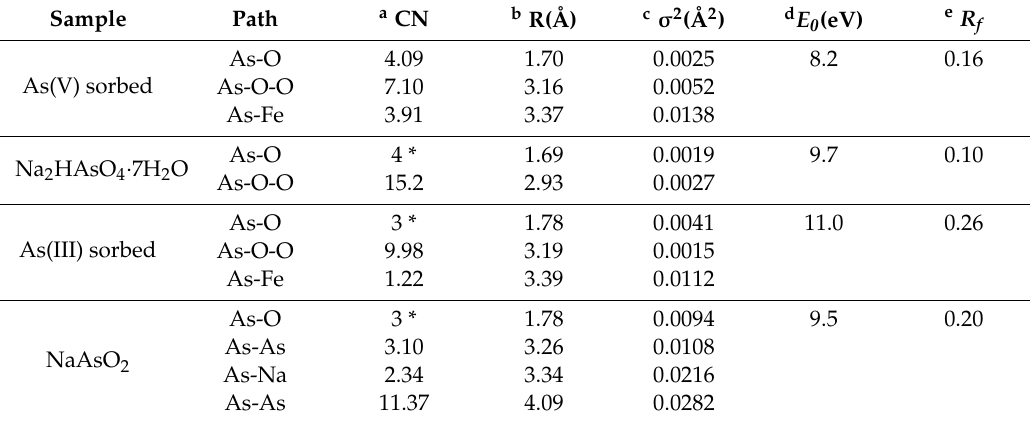
Table 6. Shell fitting results for the arsenic (III and V)-sorbed CF-NCs and reference samples. Sample Path a CN